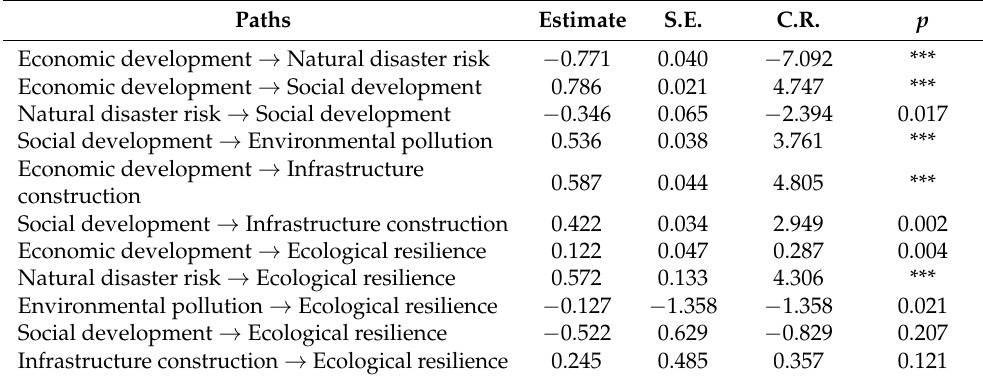
Table 5. SEM path coefficients for the identification of key driving factors of ecological resilience in the YREBML.